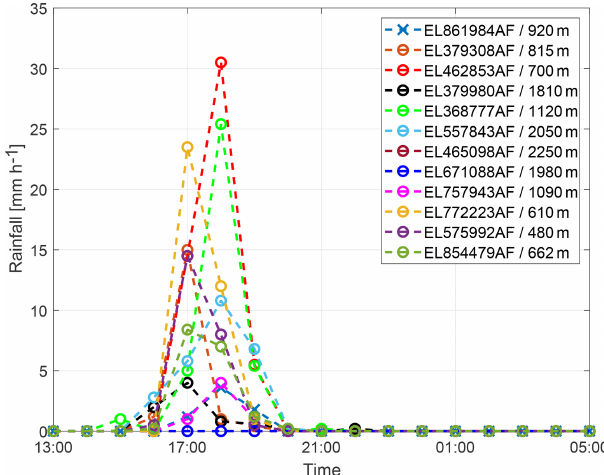
Figure 11. Rainfall amounts and altitudes of rainfall gauging sta- tions from 12 February 1999.